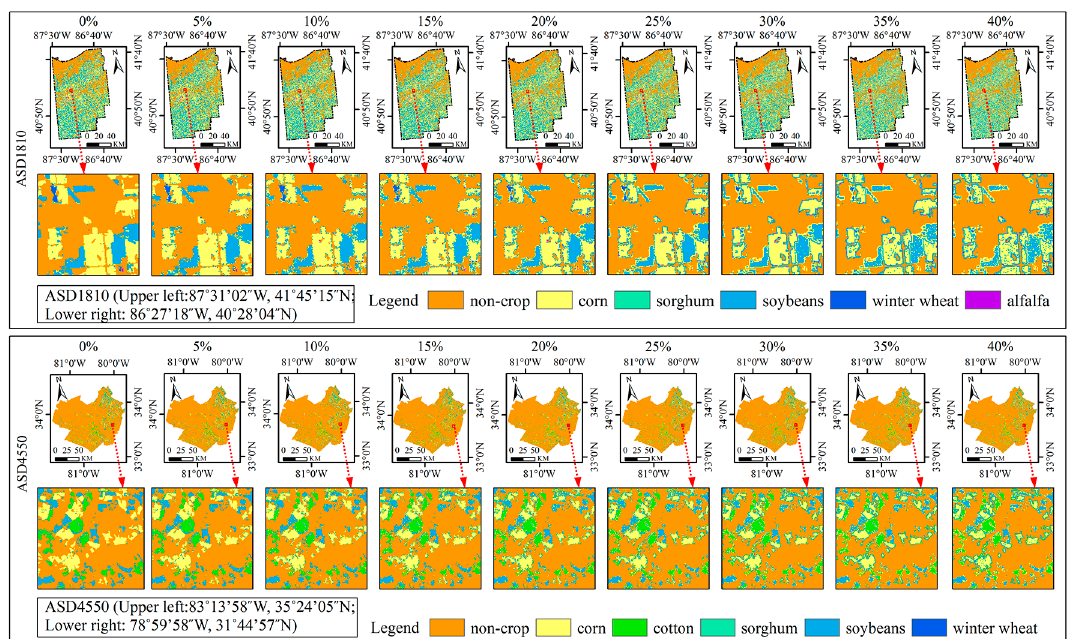
Figure 3. Error maps of two study areas. Note each column represents the maps with different error levels. The upper panel shows the base maps in ASD1810, while the lower panel shows the base maps in ASD4550. In each panel, the second row presents a sub-region within each base map.